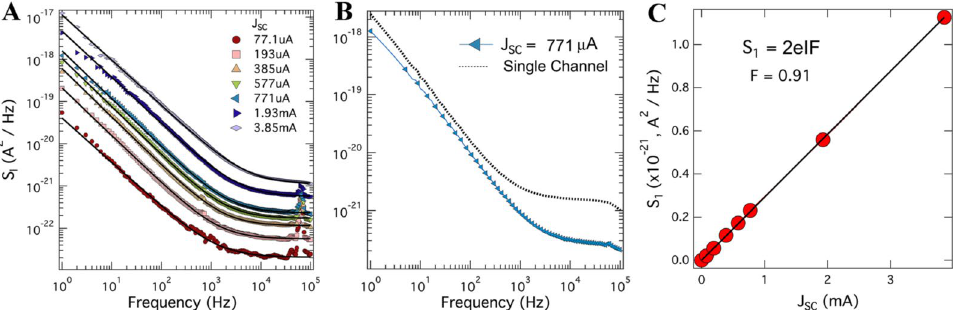
Figure 2. Current spectral density measured with the cross-correlation technique of the SHJ solar cell SC1 at short-circuit condition under red light illumination. ( A ) Frequency dependence of current noise power spectral density at 300 K under illumination with varying intensity from a narrow-spectrum red LED ( (cid:31) = 625 nm ). The legend indicates short-circuit DC current in the device. Black solid lines are fits to Eq. (1). ( B ) Comparison of a cross-correlated data set to that of a single channel showing the dominance of the front-amplifier noise on the single channel thus necessitating cross correlation. ( C ) The magnitude of frequency-independent term extracted from fitting to Eq. (2) versus short-circuit current. Solid line is a linear fit to the data, corresponding to a Fano factor F ≈ 0.9